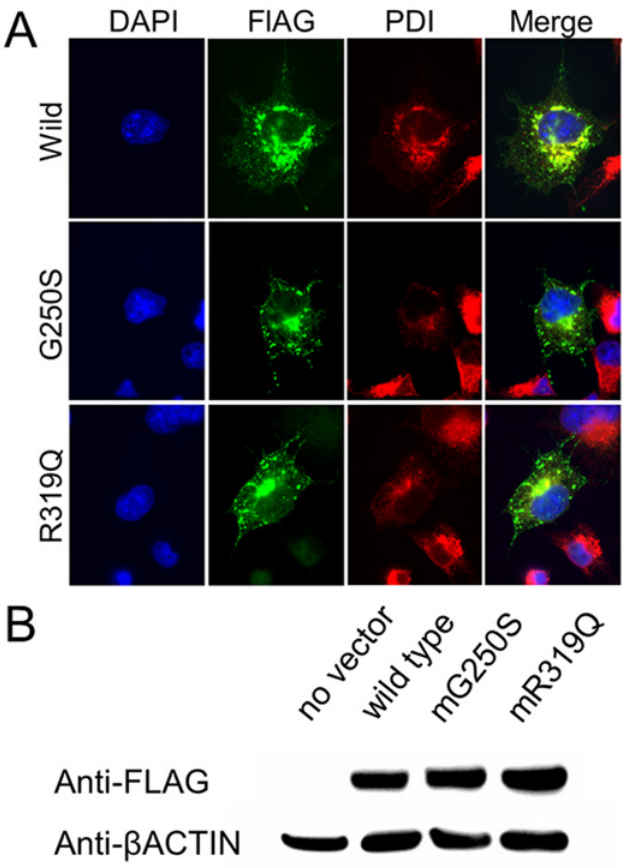
Fig 4. In vitro functional evaluation of SNVs effects. (A) Immunofluorescence staining of COS1 cells transfected with SNV-harboring CLCN6 variants. Protein disulfide isomerase (PDI) is used as marker of the endoplasmic reticulum (ER). FLAG-tagged CLCN6 is merged with PDI, indicating CLCN6 localization in the ER. (B) Western blotting analysis of cell lysates shows no difference in CLCN6